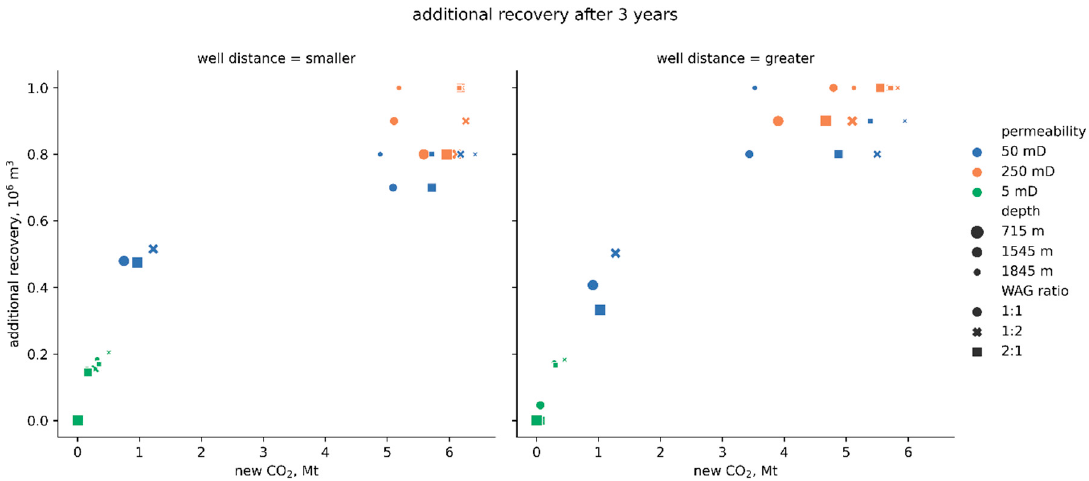
Figure A5. Additional recovery versus new CO 2 after 3 years of EOR.